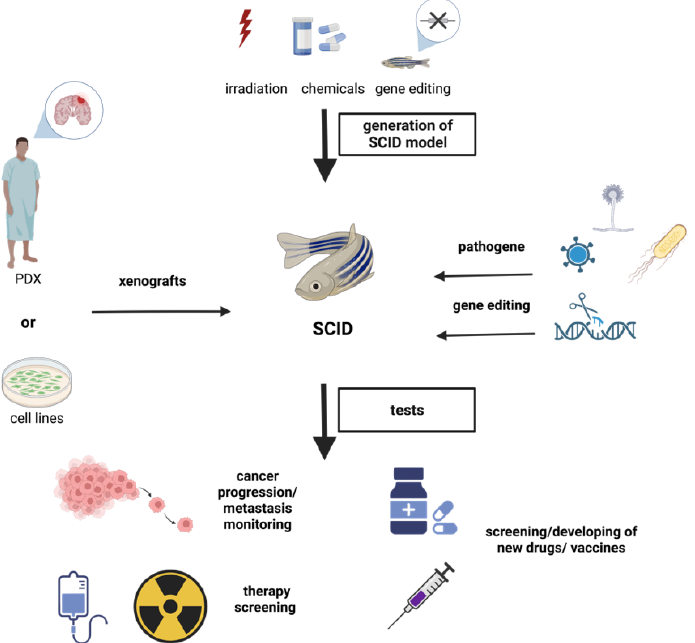
Figure 1. Avenues of research using ZF as a model to study human disease. This is an original fig- ure created in BioRender.com (accessed on 28 July